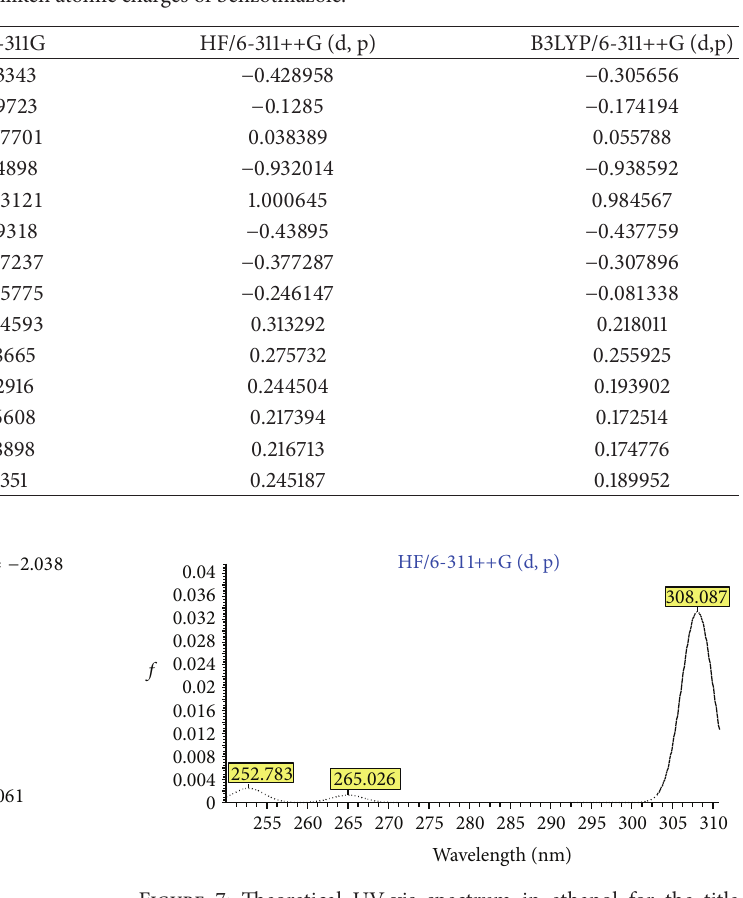
Figure 7: Theoretical UV-vis spectrum in ethanol for the title molecule calculated with the TD-HF/6-311++G (d, p)